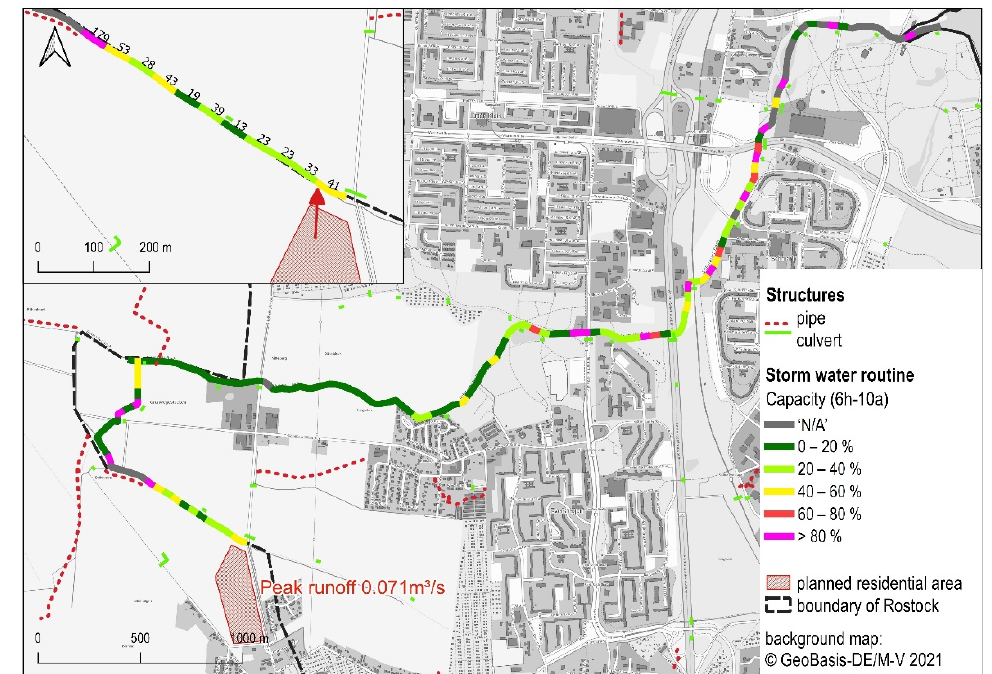
Figure 14. Stream capacity in plan state calculated with the storm water routine for the rain event 6h-10a.